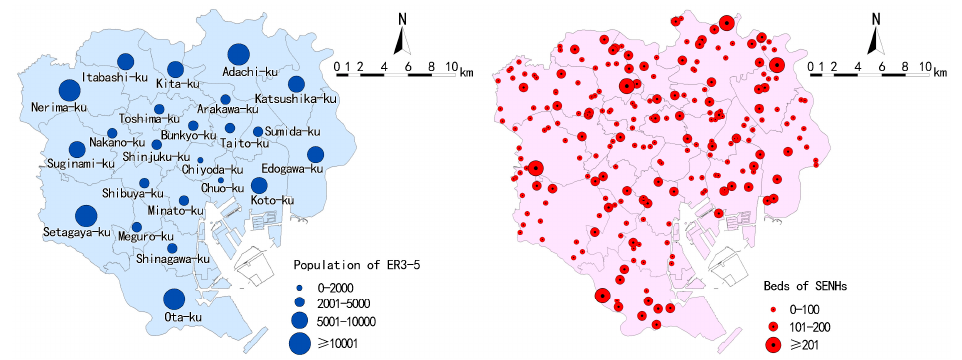
Figure 2. Distributions of the population of the elderly who require care levels 3–5 (ER3 ‐ 5) ER3 ‐ 5 and beds.